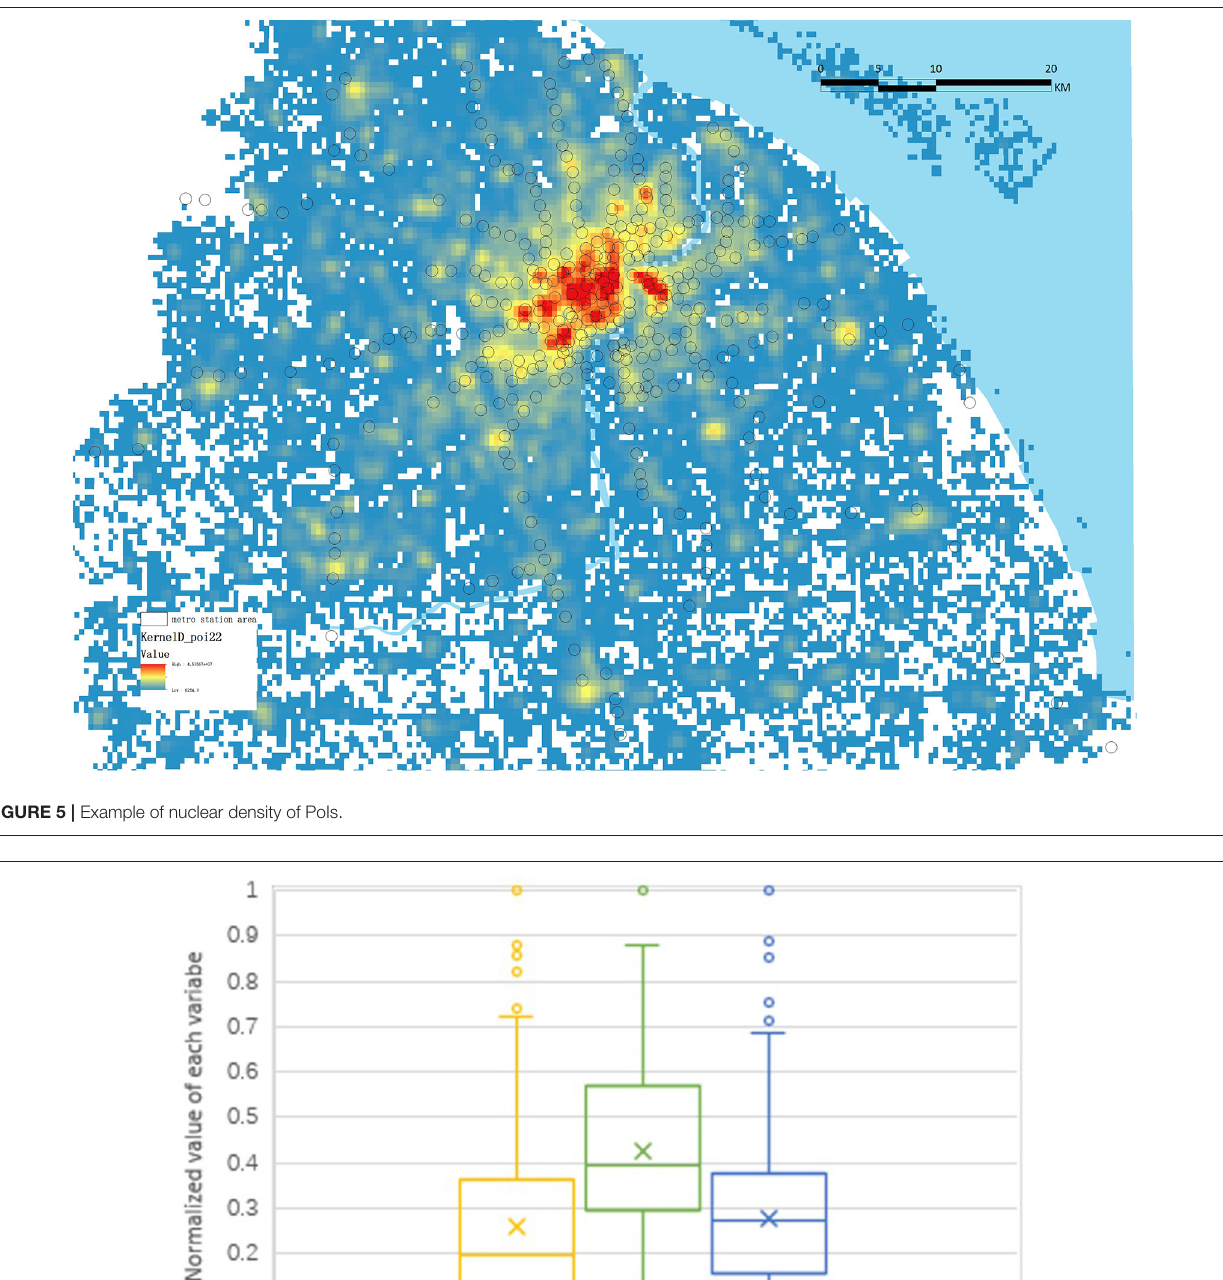
FIGURE 6 | Boxplots for T, O, and D values